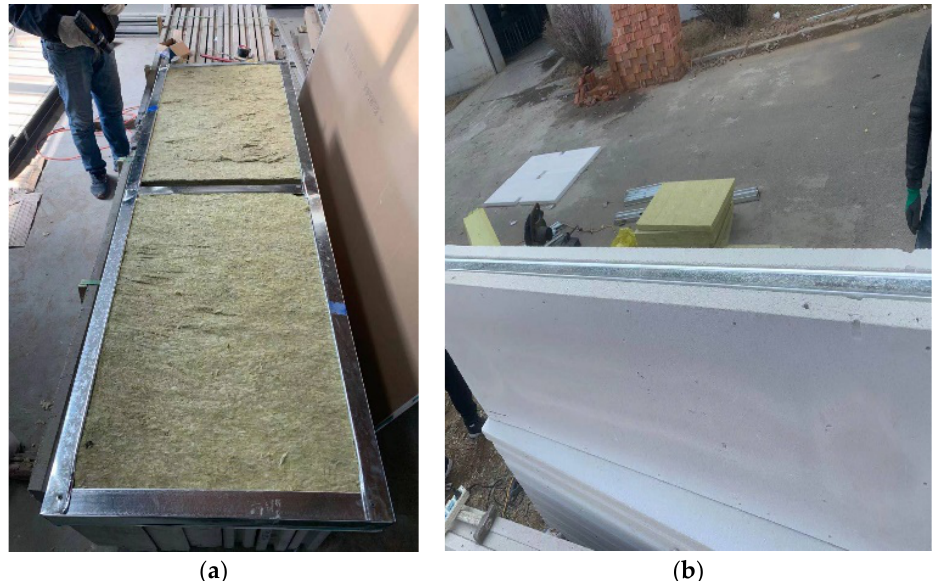
Figure 3. Fabrication of the sandwich wall panel: ( a ) assembled insulation layer; ( b ) self-tapping screw connection at the edge.